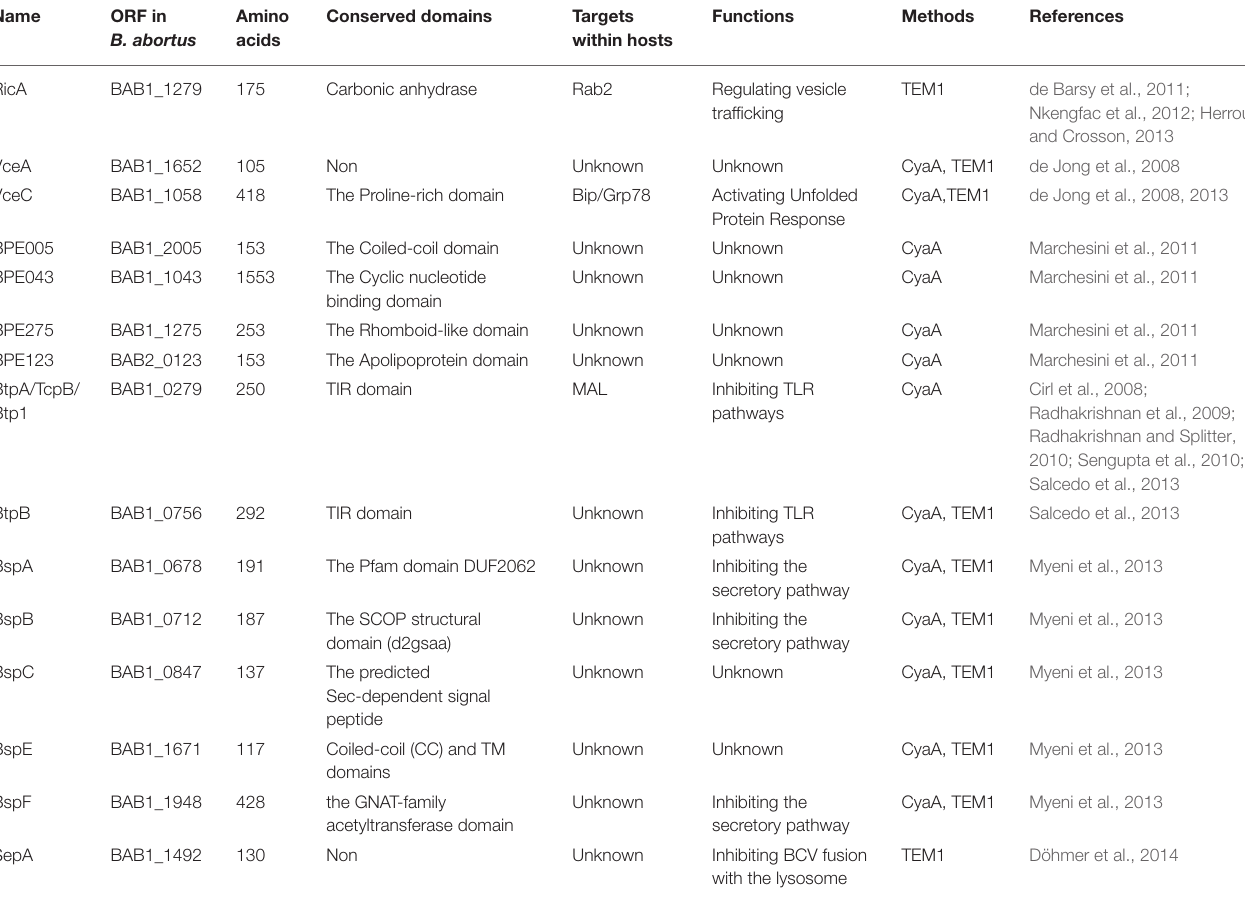
TABLE 1 | The 15 effectors secreted by Brucella through